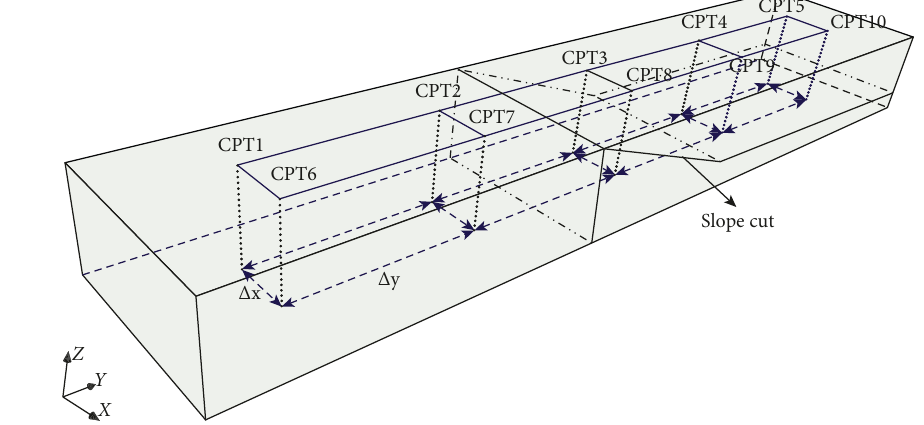
Figure 1: Example illustration of CPT sampling strategy ( k � 2, m �